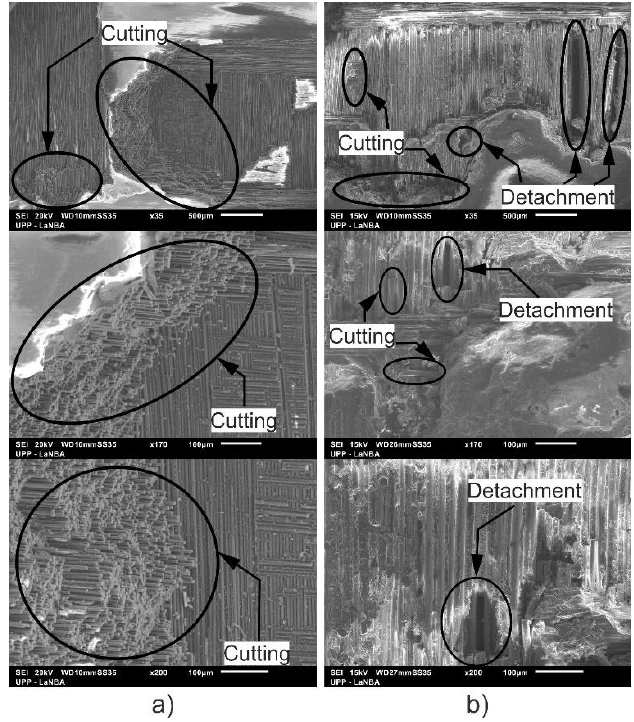
Figure 9. Cutting and detachment action: ( a ) carbon fiber and ( b ) glass fiber.